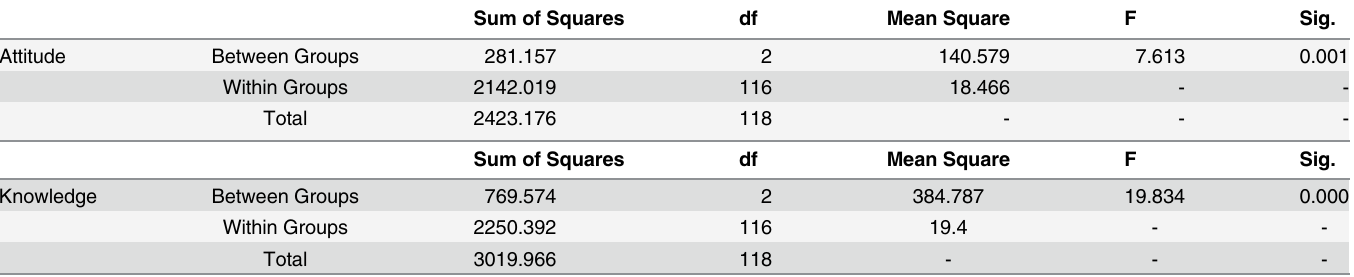
Knowledge Between Groups Within